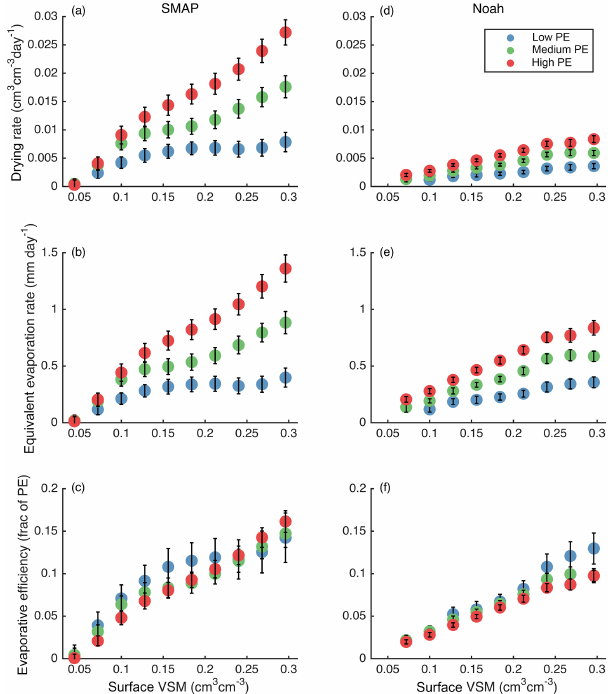
Figure 7. Drying rates and efficiencies for SMAP (a–c) and Noah (d–f) as a function of surface soil moisture content and three PE terciles. The top row shows drying rates, the middle row shows equivalent evaporation rates, and the bottom row shows evaporative efficiencies. Markers show median values. Error bars show standard